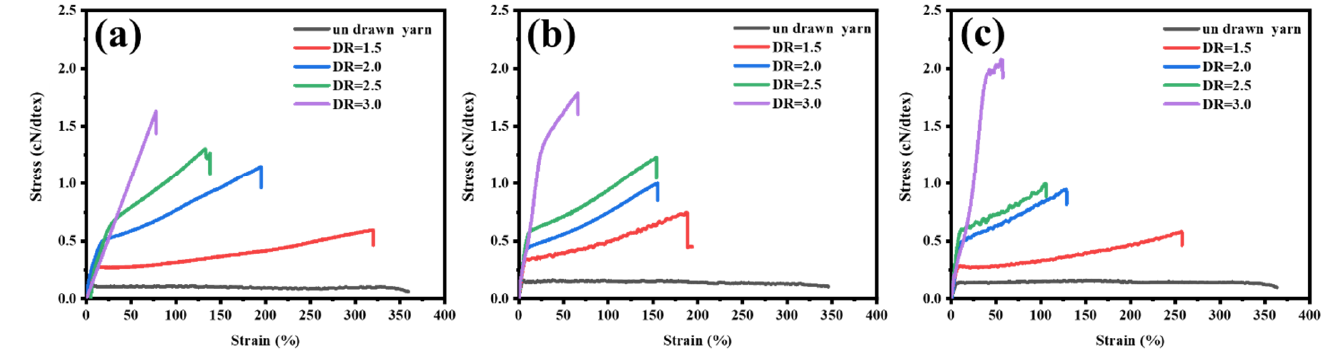
Figure 10. Tensile properties of fiber at various draw ratios: ( a ) PBHA-C5/PBT = 33/67, ( b ) PBHA- C5/PBT = 30/70, and ( c ) PBHA-C5/PBT = 27/73.